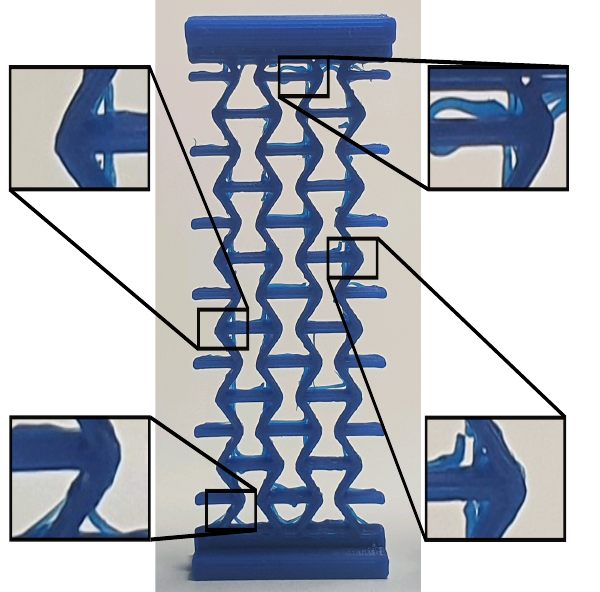
Figure 11. Example of a re-entrant lattice-flexure hinge with some microstructural defects found after the manufacturing process. Table 1. Comparison and error percentage (%E) for the measured average displacement and F / δ compared with those from